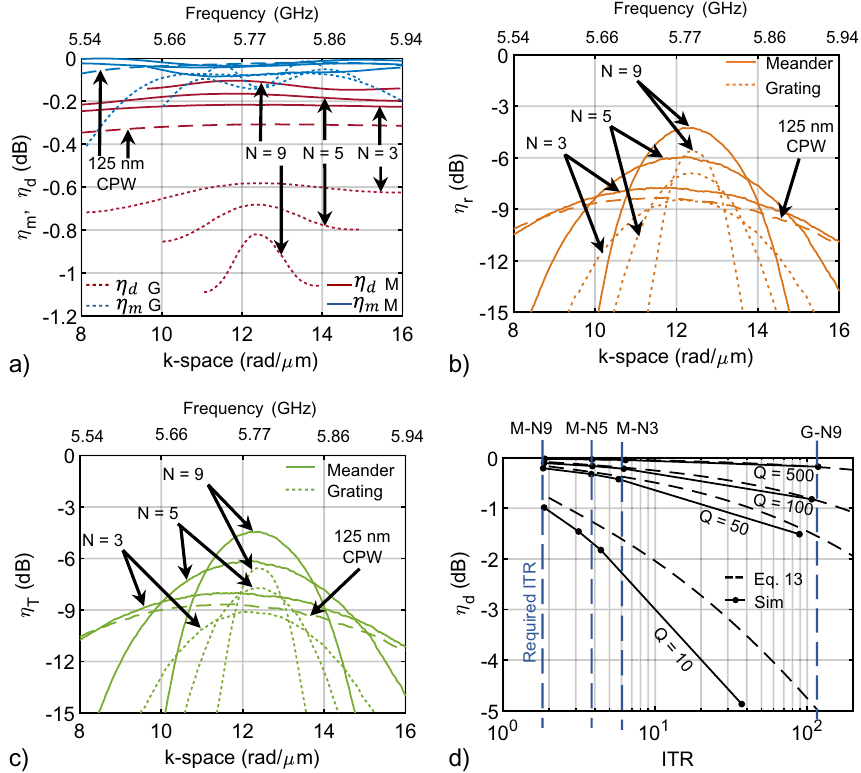
Figure 6. ( a ) The match efficiency for L-section, lumped-element, MNs ( Q e = 100 ) designed for meander (solid), grating (dotted), and CPW (dashed) transducers are shown in blue, whereas the dissipation efficiency of each network is shown in red. ( b ) plots radiation efficiency (Eq. 4 for meander (solid), grating (dotted), and CPW (dashed) transducers simulated in HFSS. The total efficiency (Eq. 1) is shown in ( c ) for meander (solid), grating (dotted), and CPW (dashed) transducers. ( d ) Dissipation efficiency as a function of ITR for MNs of constant quality factor Q e = 10, 50, 100, and 500 . The approximation in Eq. (8) is plotted as a dashed, black line. The solid black line with markers represents the dissipation efficiency at the ITR achieved with the finite-Q networks for a grating with N = 9, and meanders with N = 3, 5, and 9. The required ITR for each device to achieve a perfect match is shown by the dashed blue lines, but as a result of adding finite Q after designing the networks, they do not provide a perfect